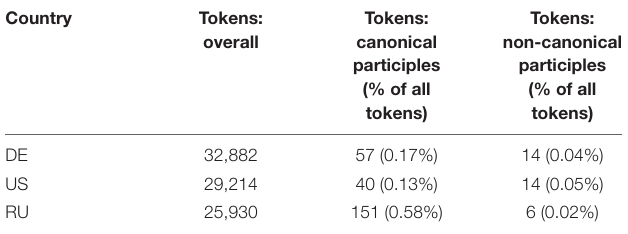
TABLE 2 | Frequency of tokens and participles across different groups.